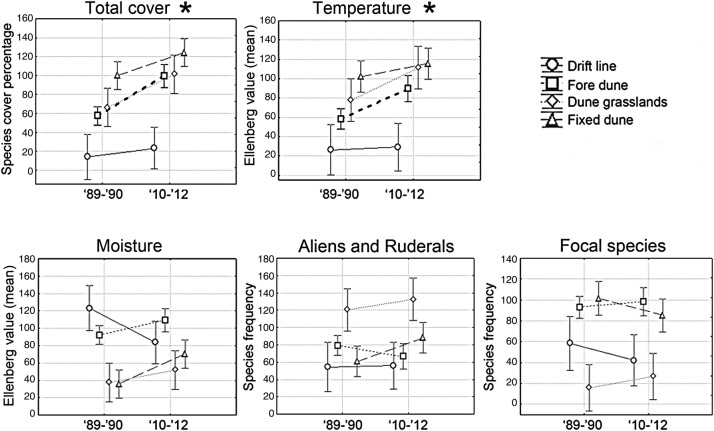
Comparison of species cover, mean Ellenberg indicator values for temperature and moisture, and species guild frequency between the relevés sampled in 1989–90 and 2010–12 by habitat type. Vertical bars denote 0.95 confidence intervals. The black stars and the thick dashed lines indicate significant differences found using the post hoc Tukey HSD tests (P < 0.05).